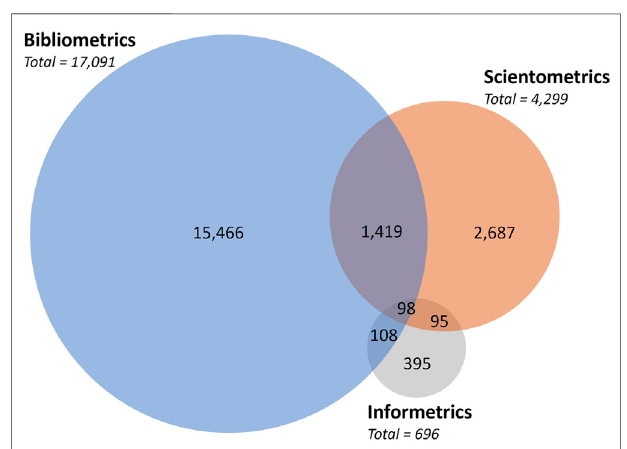
FIGURE 3 | Number of articles containing the keywords “ bibliometrics ” , “ scientometrics ” or “ informetrics ” in their title, abstract, or indexed keywords.